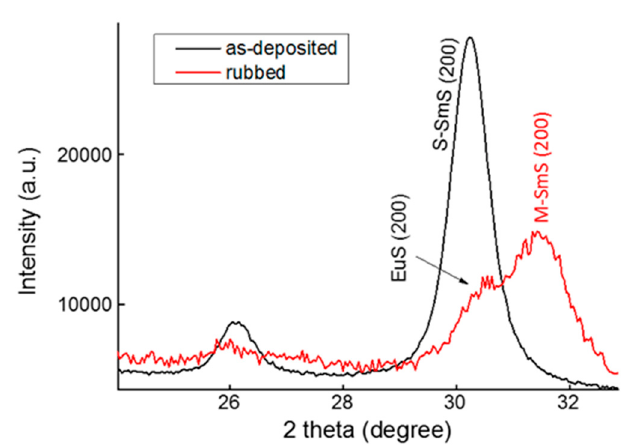
Figure 3. XRD patterns of an as-deposited SmS/EuS/SmS (35/30/35 nm) tri-layer deposited at 250 °C (black curve), and after rubbing (red curve).